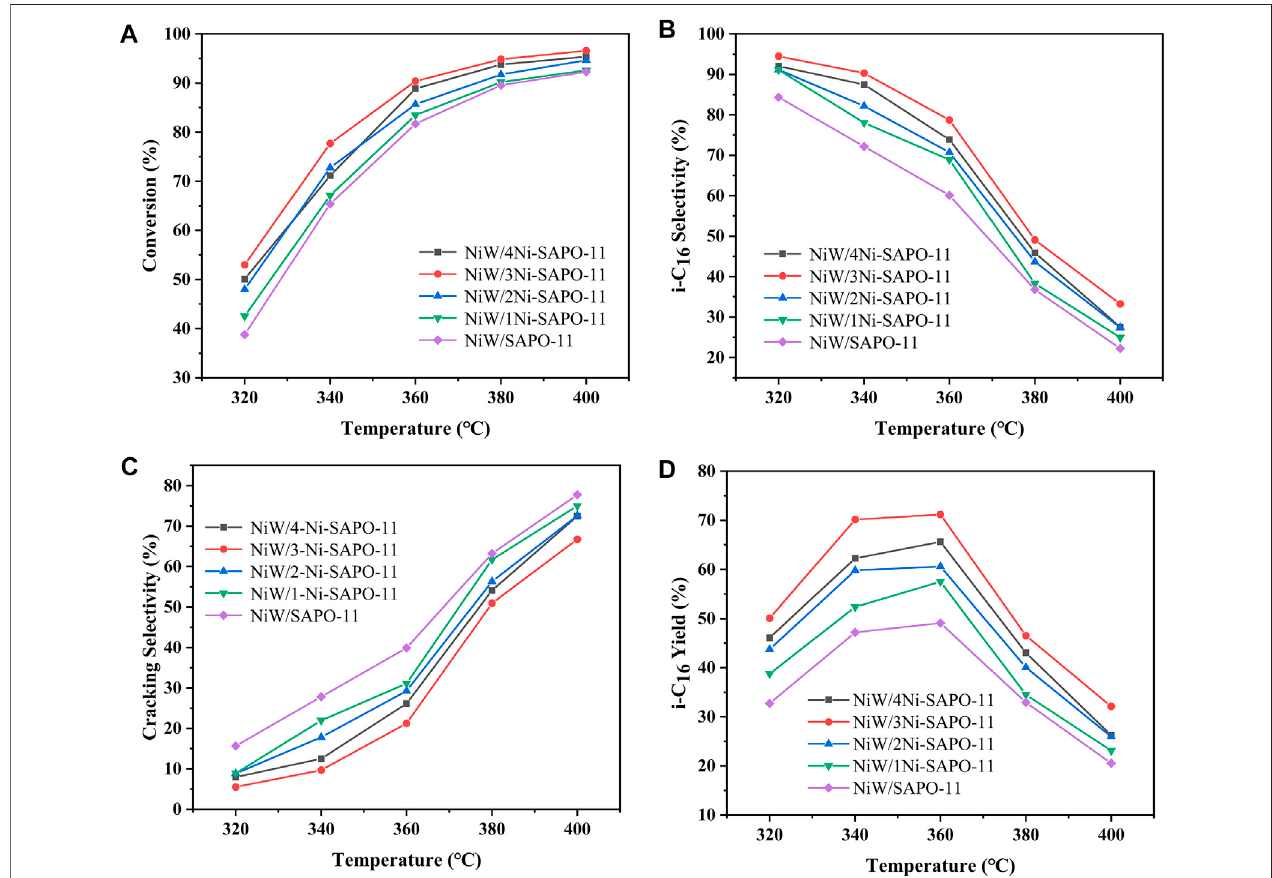
FIGURE 10 | Catalytic performance of the different catalysts: (A) n-C 16 conversion, (B) i-C 16 selectivity, (C) cracking selectivity, and (D) i-C 16 yield.